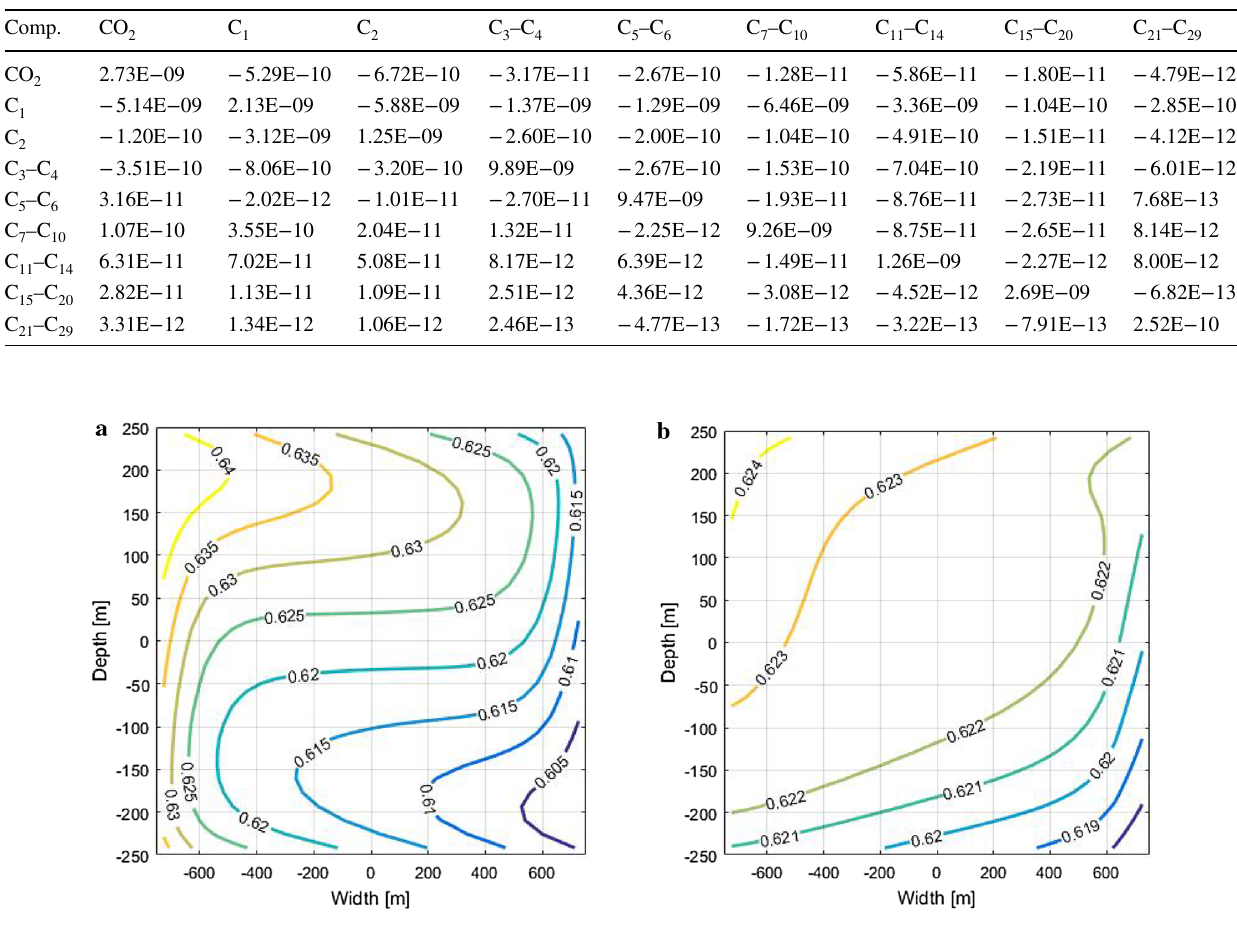
Fig. 4 a Contour plot of C 1 composition based on the developed model. b Contour plot of C 1 composition based on the Ghorayeb model